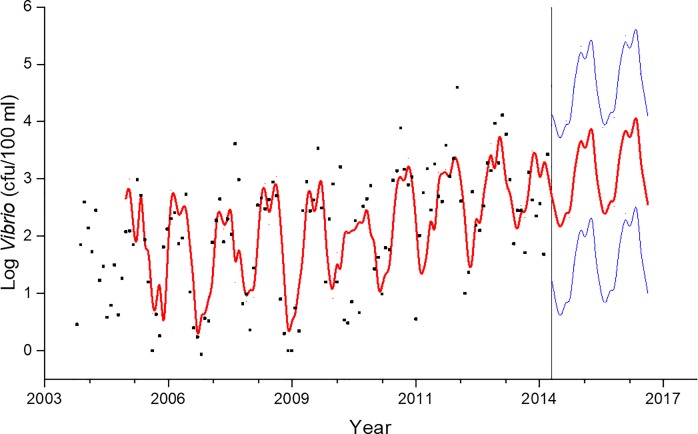
Seasonal ARIMA model (1,1,1)(1,1,1) of mean monthly log Vibrio spp. data at station 70S.Dots are actual measurements, red line represents modeled abundance, and blue lines are the 95% confidence interval.